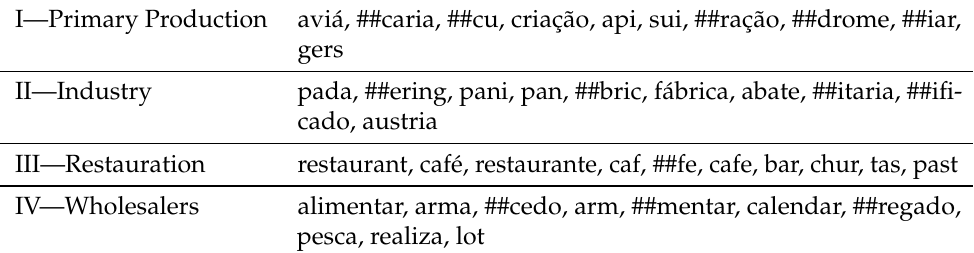
Table 20. Top-10 features for economic activity prediction using BertTokenizer with SVM.